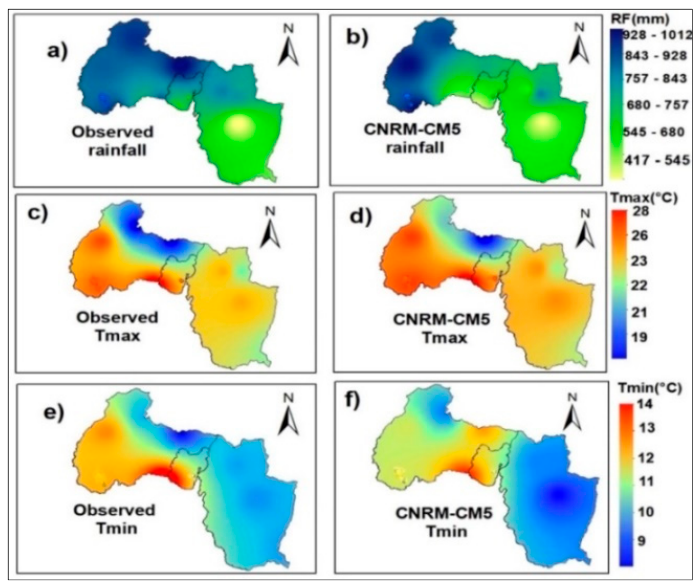
Figure 2. Spatial distribution of observed and CNRM-CM5 model annual mean rainfall (mm/year) and annual mean temperatures (T max and T min (°C)) for ( a ) observed and ( b ) CNRM-CM5 rainfall ( c ) observed T max , ( d ) CNRM-CM5 T max , ( e ) observed T min , and ( f ) CNRM-CM5 T min over the ZLB